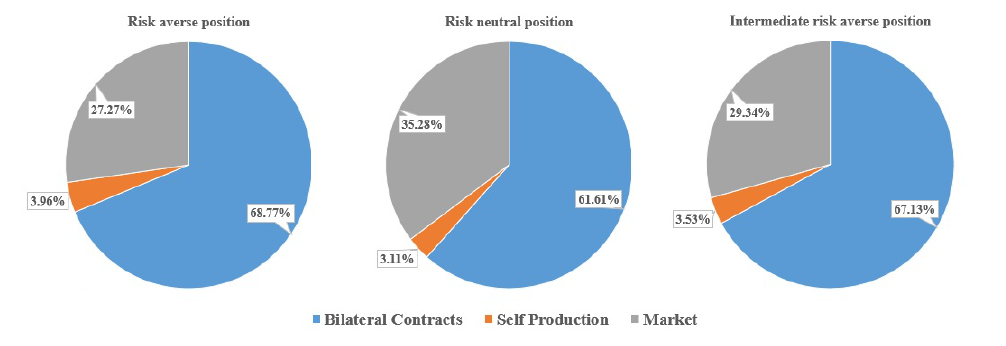
Figure 7. Procurement costs.